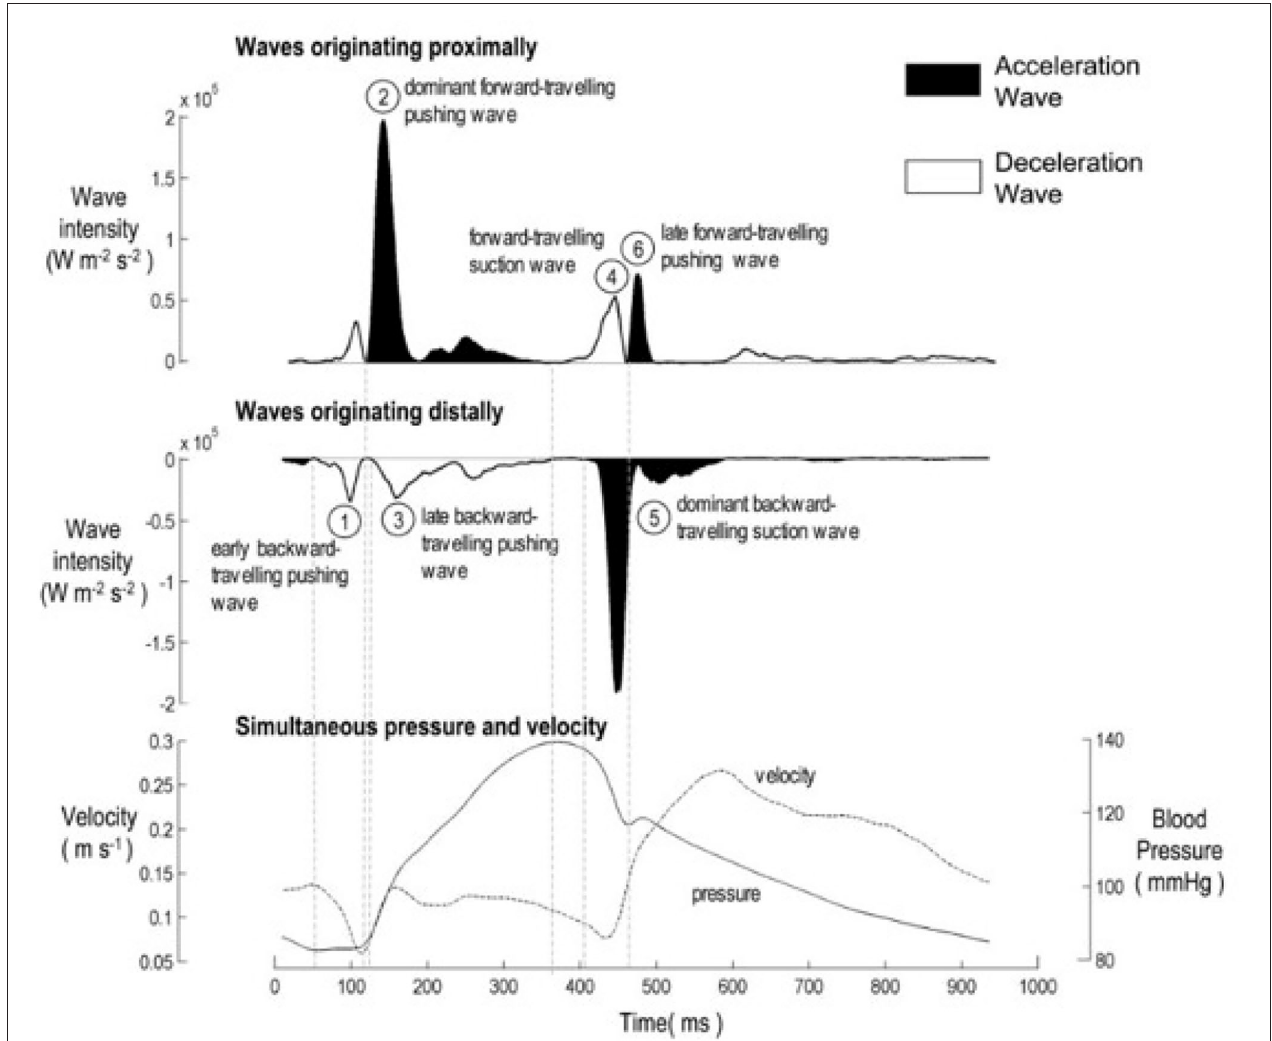
FIGURE 1 | The six characteristic waves in healthy unobstructed coronary arteries, adapted from Davies et al. (6). (Top) Forward wave intensity originating near the aorta. (Middle) Backward wave intensity originating near the microcirculation. (Bottom) Total pressure and velocity waveforms used in the calculation of wave intensity analysis. The peaks are identified as 1: Early Backward Compression Wave ( BCW 0 ); 2: Forward Compression Wave ( FCW 1 ); 3: Backward Compression Wave ( BCW 1 ); 4: Forward Expansion Wave ( FEW 2 ); 5: Backward Expansion Wave ( BEW 2 ); 6: Late Forward Compression Wave ( FCW 2